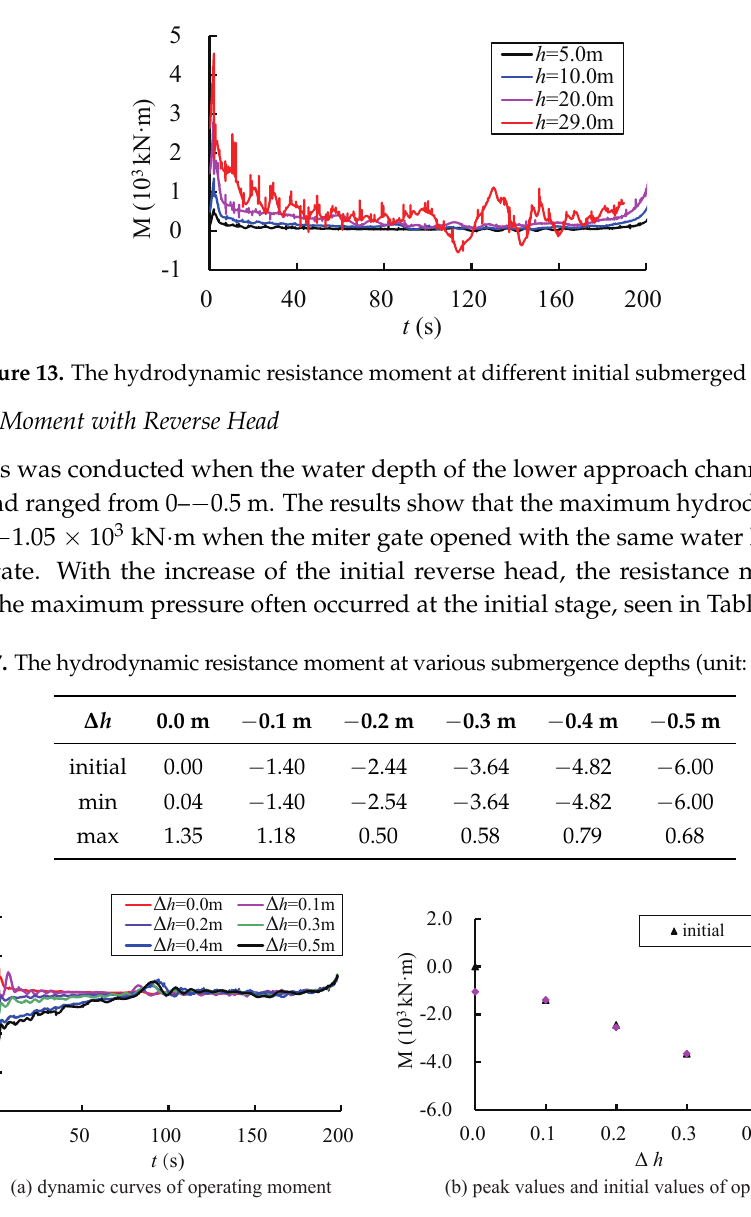
Figure 14. The hydrodynamic resistance moment of over-emptying for various reverse heads ∆ h